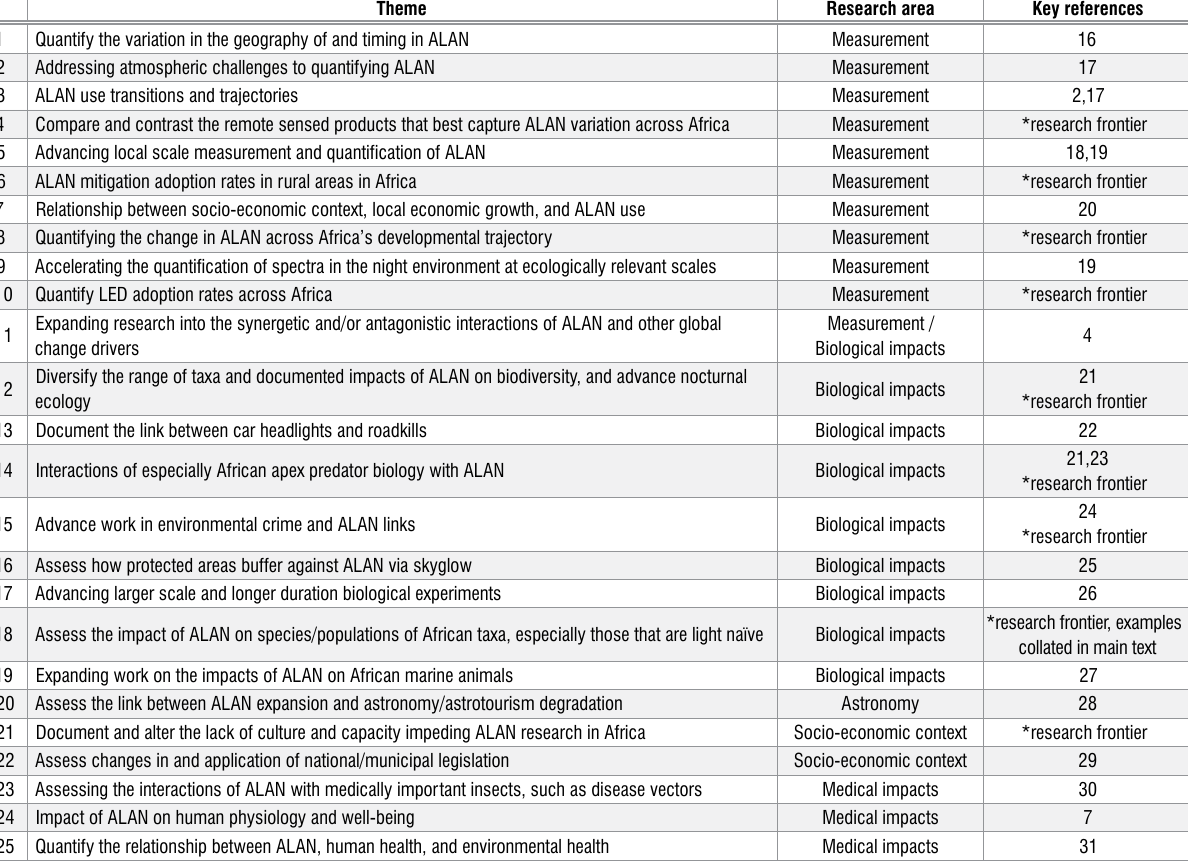
Exemplar research themes with key references to advance artificial light at night (ALAN) research in Africa